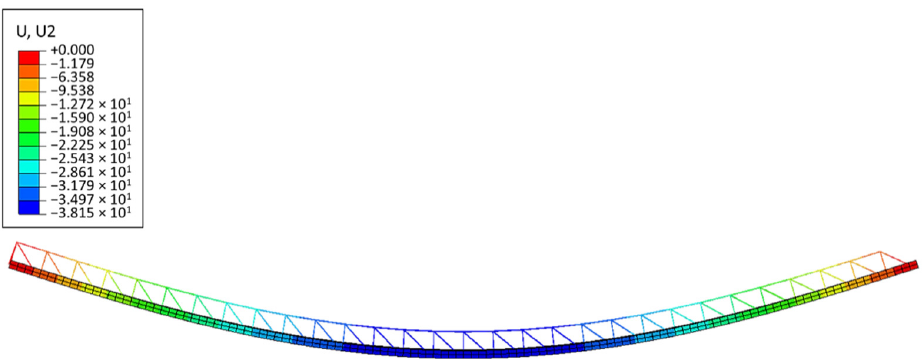
Figure 12. Vertical displacements of Model-2 (Type-EQ).